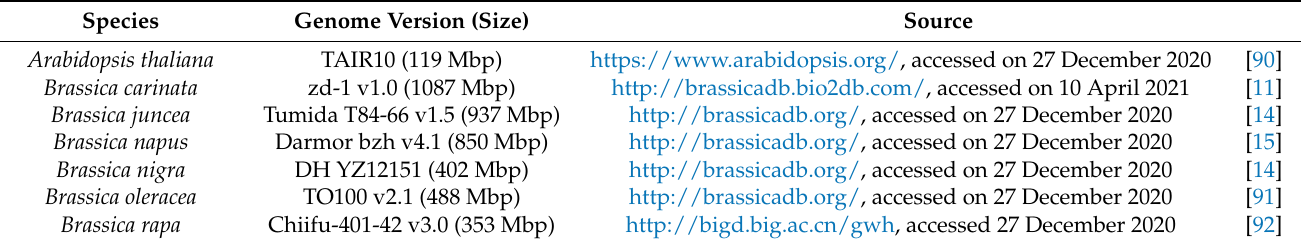
Table 2. Seven Brassicaceae species with their corresponding genome version and size used in this